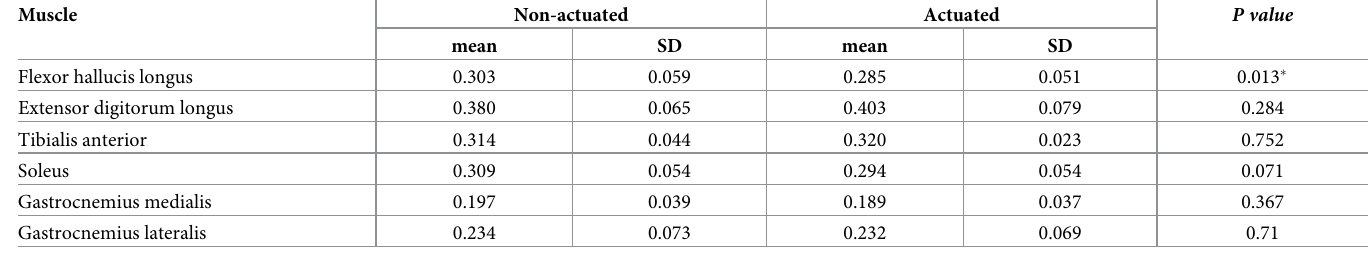
Table 1. Means, standard deviation (SD) and statistical results for normalized muscle activities during walking with the MTP assistive device under actuated and non-actuated conditions. Muscle